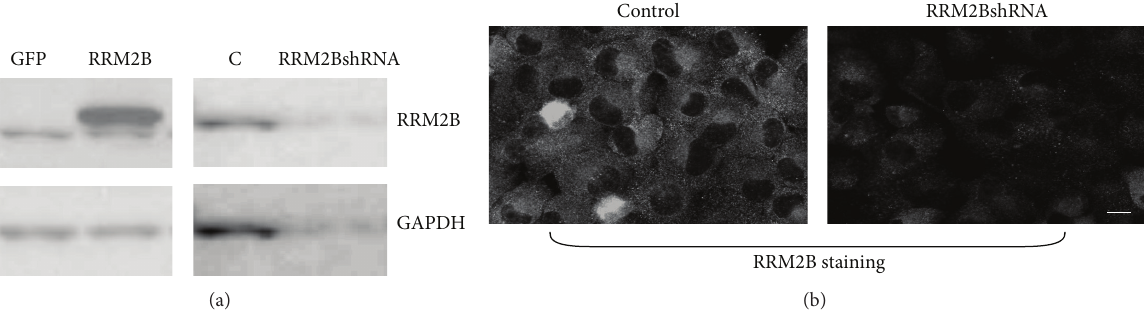
Figure 1: Expression of RRM2B in the H1299 stable cell lines. H1299 stable cell lines were selected as described in the Section 2. Cells were harvested for (a) Western blot analysis or (b) fixed for immunofluorescence assay. Anti-RRM2B and GAPDH were applied in the